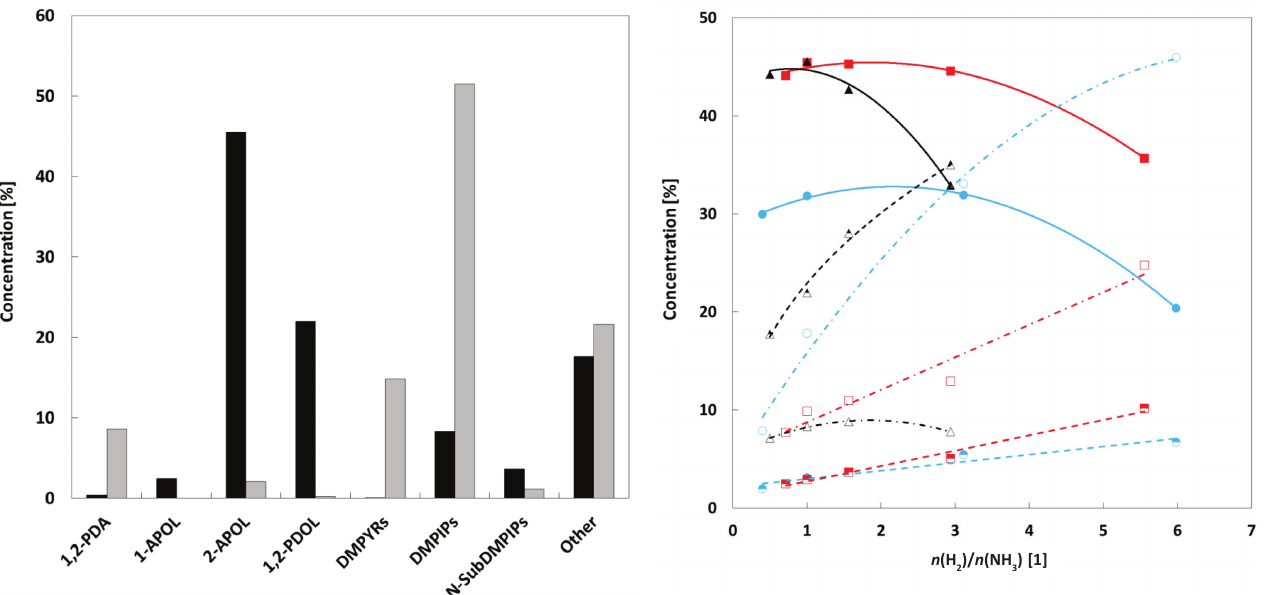
Fig. 2 – Effect of catalyst on the product distribution of the reductive amination of acetol by ammonia in the gas phase. Reaction conditions: 130 °C (Ni-based catalyst) or 210 °C (Cu/ Cr catalyst), molar ratio of acetol/H 0.078 h –1 , total conversion of acetol.  Ni-based catalyst (KL6527-CY);  Cu/Cr catalyst (T-4466).